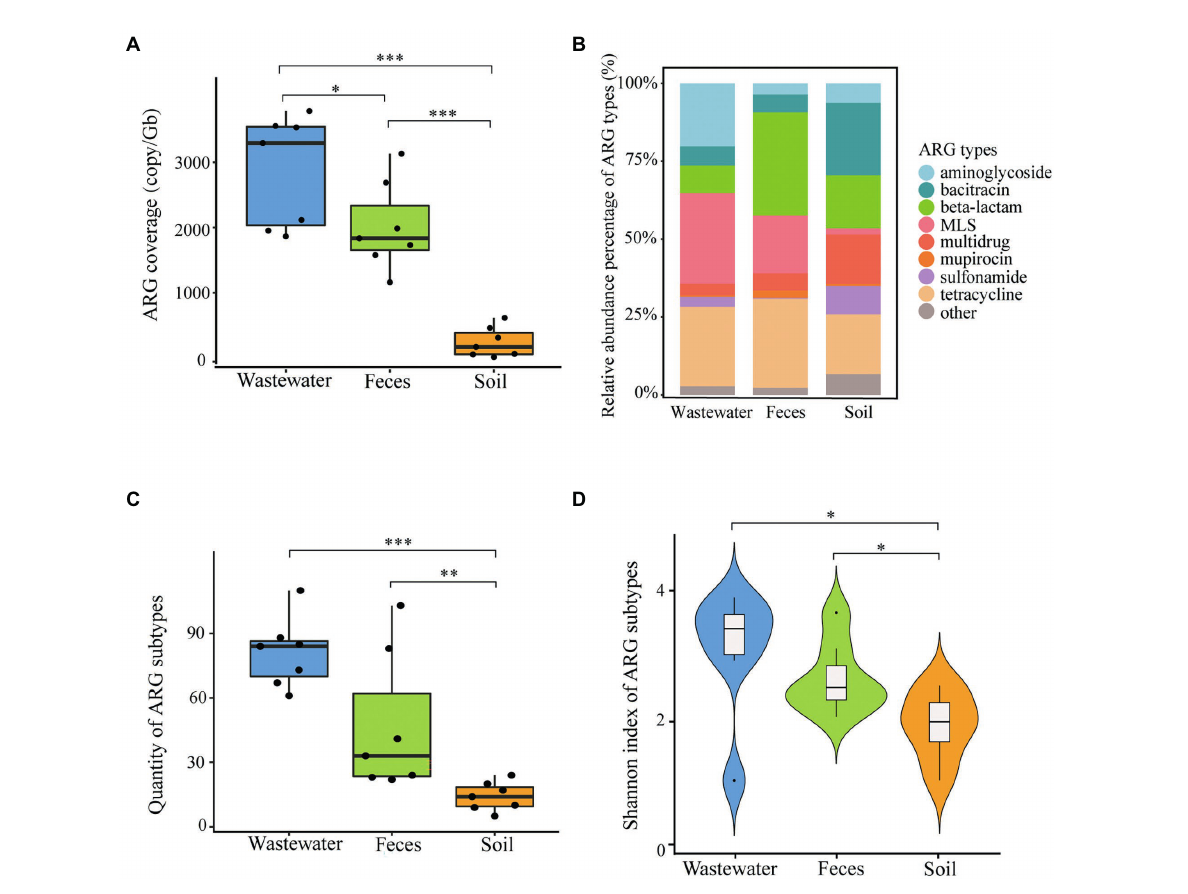
FIGURE 2 ARG profiles in dairy wastewater, feces, and soil. (A) Total ARGs coverage of each environmental sample. (B) ARG types composition of three sample types. (C) ARG subtypes quantity across three sample types. (D) Shannon index of ARG subtypes across three sample types. * P < 0.05; ** P < 0.01; and *** P <